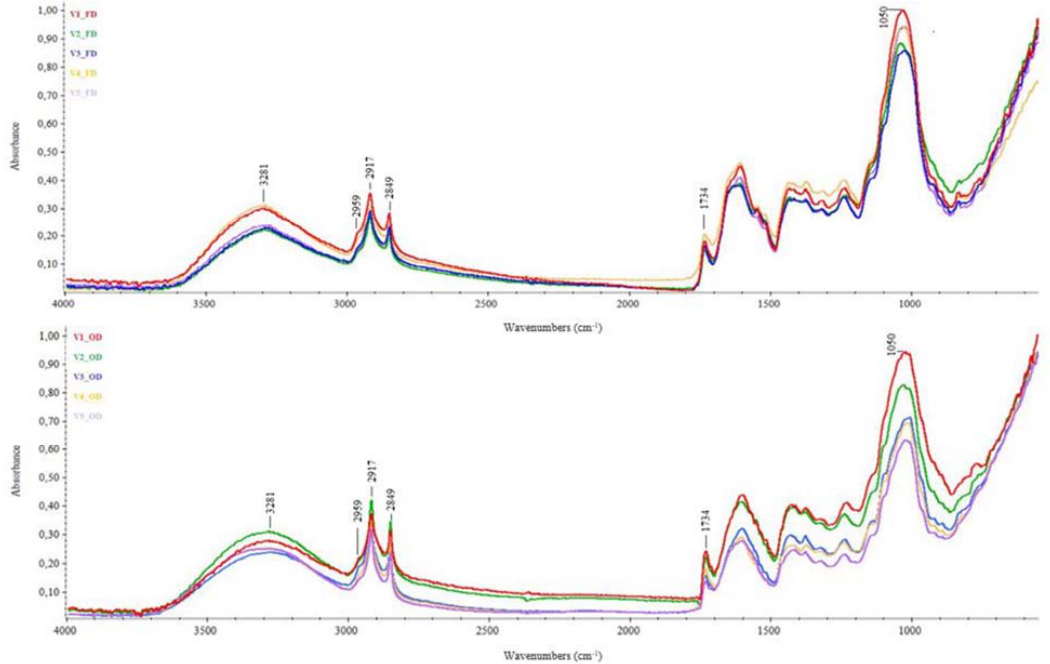
Figure 2. Average IR spectra of Humulus lupulus leaves from different varieties: influence of genotype on the applied treatment. FD—freeze-dried samples; OD—oven-dried samples. V1—Chinook hop leaves; V2—Centennial hop leaves; V3—Comet hop leaves; V4—Columbus hop leaves; V5—Cascade hop leaves.